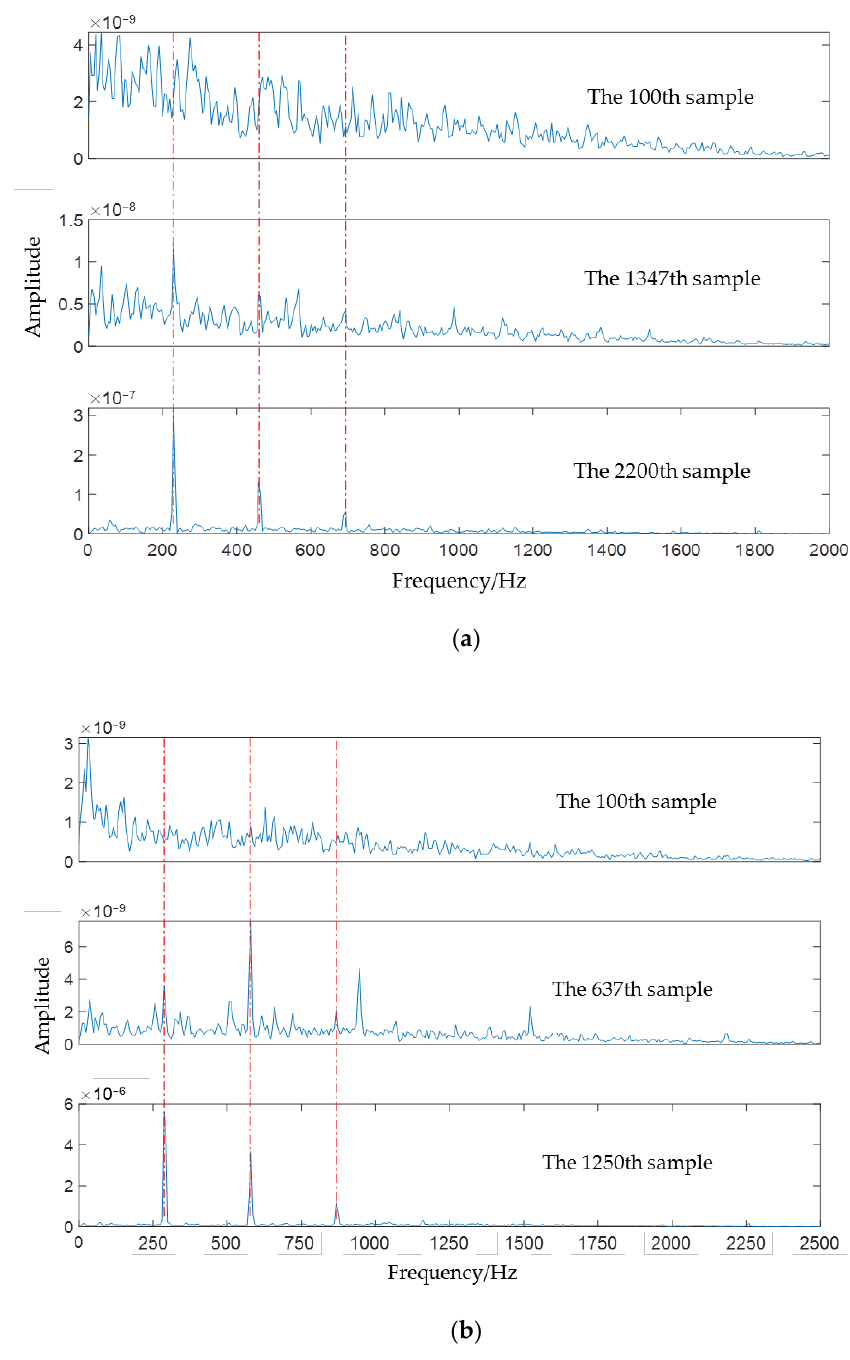
Figure 6. Spectrum of bearing fault at different sample points ( a ) PHM1_3 ( b ) XJTU1_1.